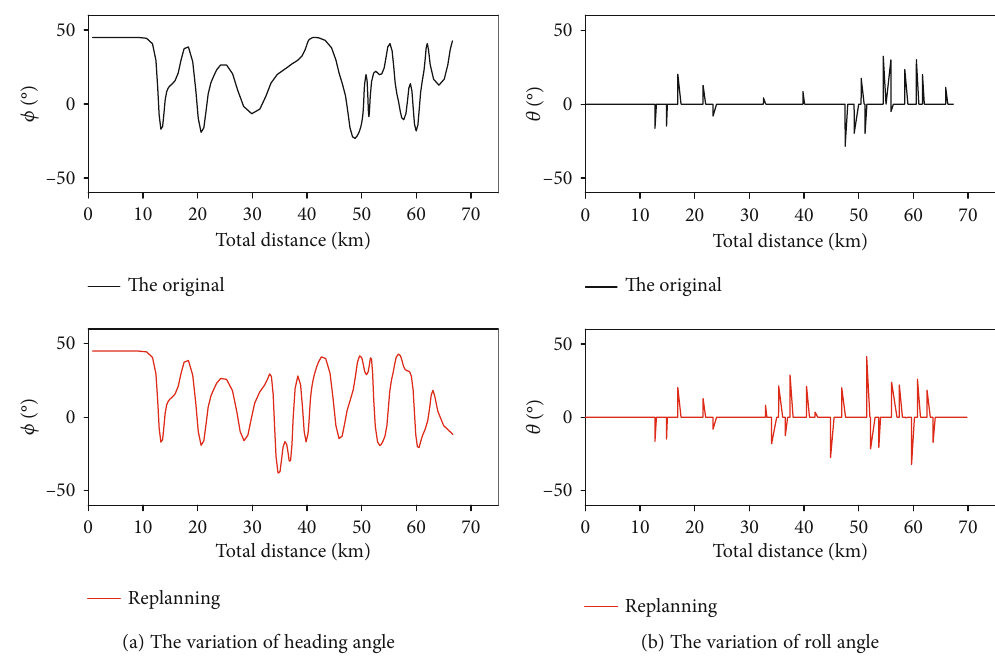
Figure 12: The variation of attitude angle that performed by improved A-Star algorithm in the third scenario.